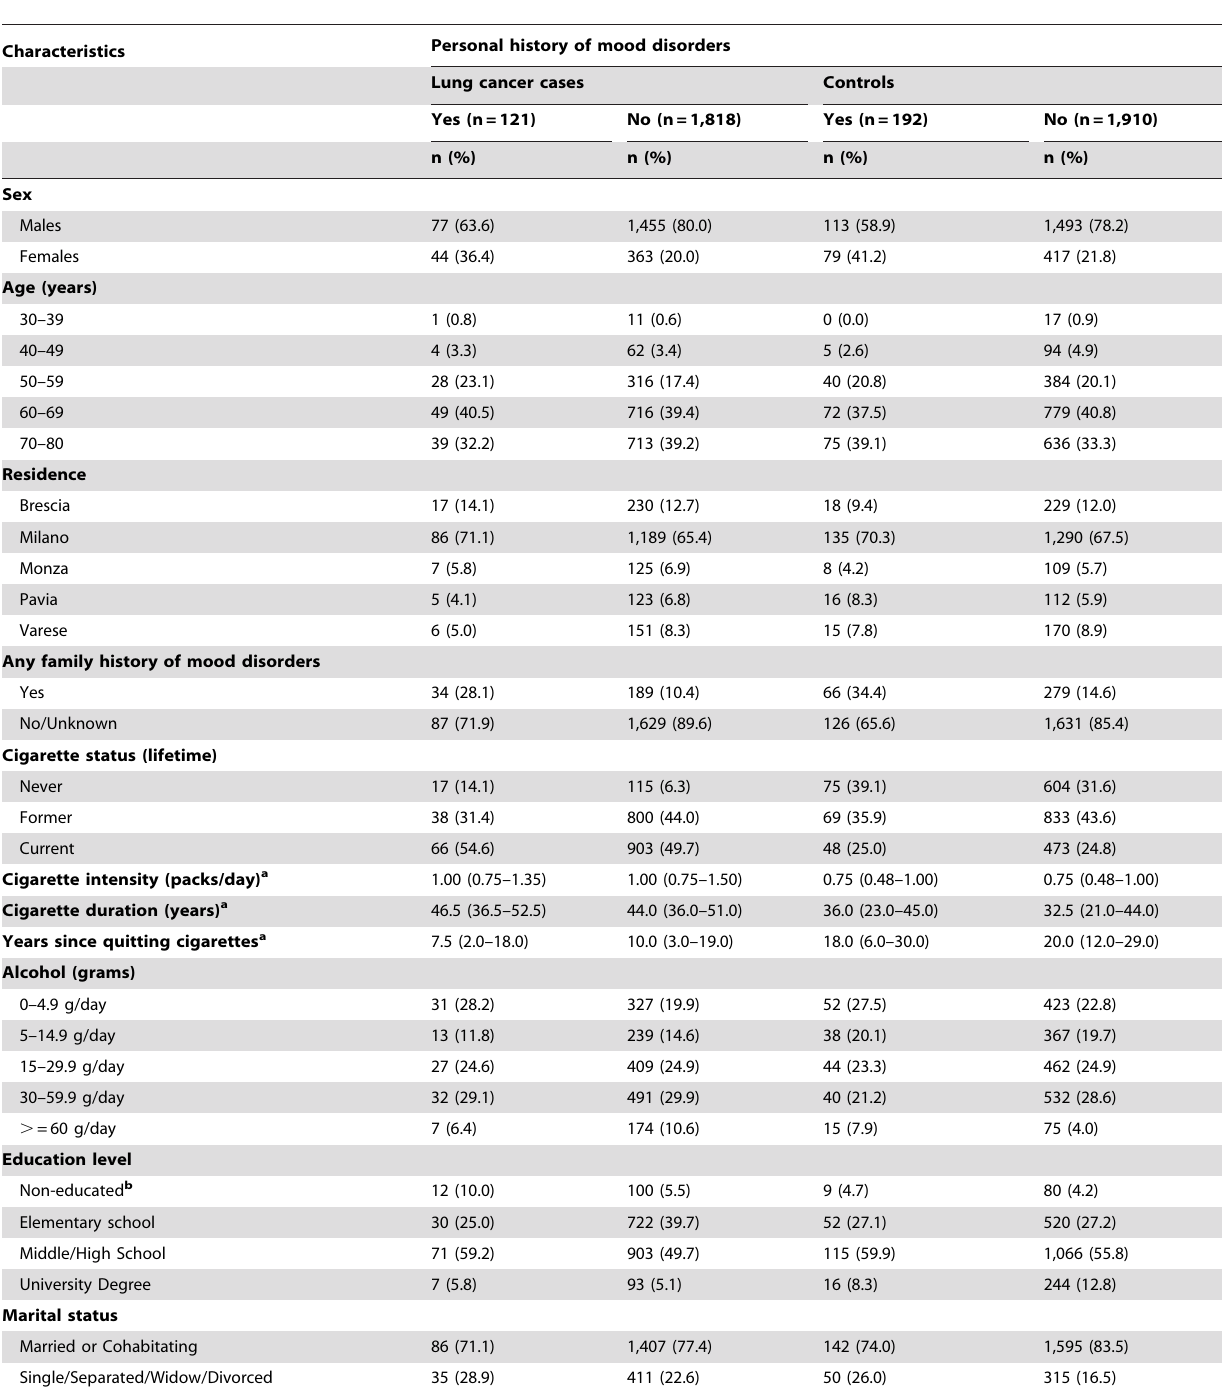
Table 1. Numbers and percentages of cases and controls with a personal history of mood disorders by demographic and behavioral characteristics in the EAGLE Study, Italy,